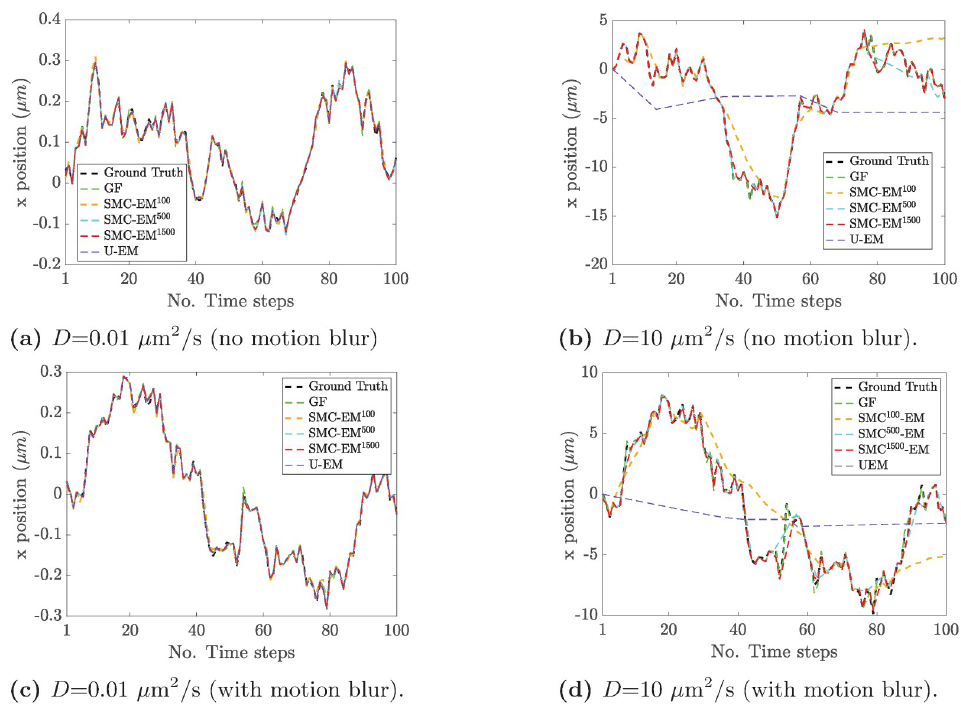
Fig 11. Typical localization performance of GF, SMC-EM, and U-EM. (green) GF, (orange) SMC-EM with 100 Monte Carlo samples, (cyan) 500 Monte Carlo samples, (red) 1500 Monte Carlo samples, and (purple) U-EM at a diffusion coefficient of (a,c) 0.01 μ m 2 /s and (b,d) 10 μ m 2 /s, both (a,b) without and (c,d) with motion blur.